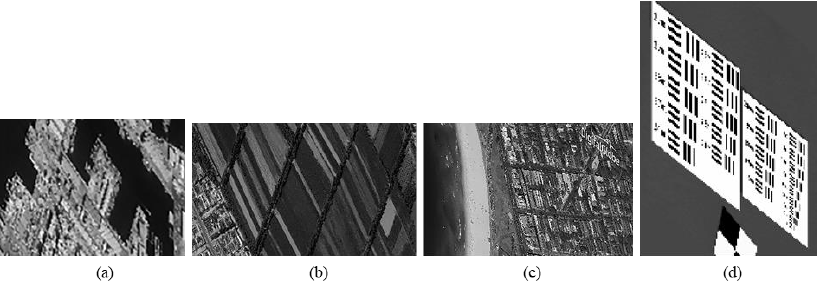
Figure 8. CMOS2 oblique-mode sampling simulation images: ( a ) seashore remote-sensing image; ( b ) farmland remote-sensing image; ( c ) city remote-sensing image; ( d ) target image.